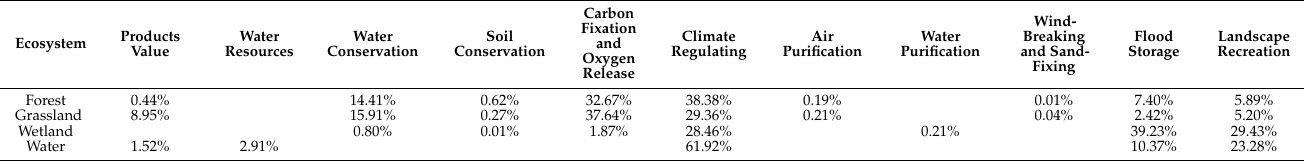
Table 3. Contribution rate of ecosystem functional services value of LUCC.